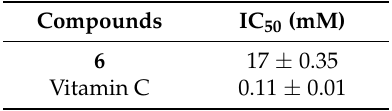
Table 3. 1,1-Diphyl-2-picrylhydrazyl (DPPH) free radical scavenging activity of compound 6 # .